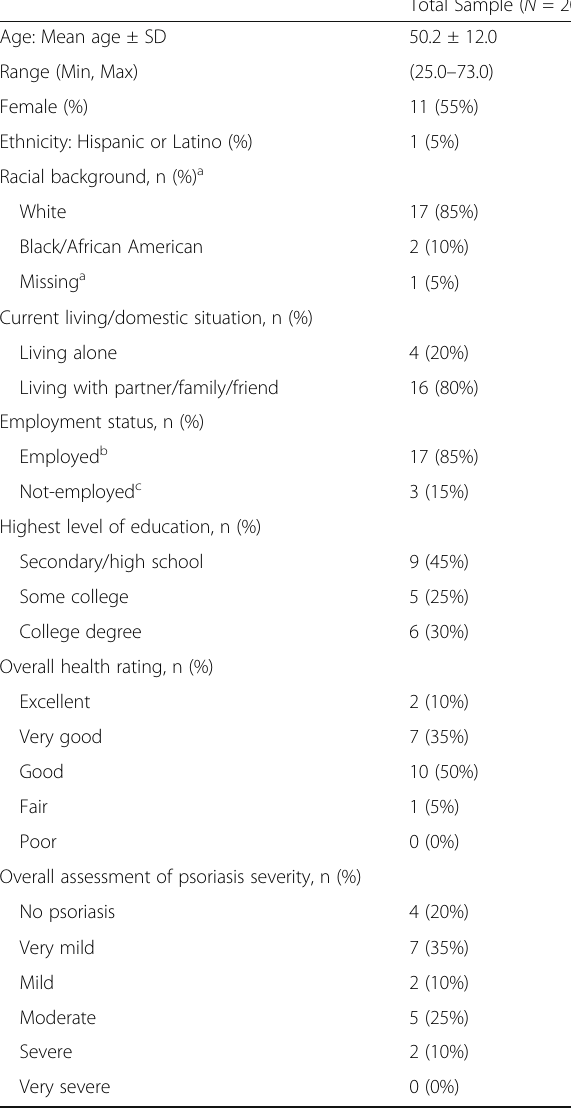
Table 1 Participant Self-Reported Sociodemographic and Clinical Characteristics